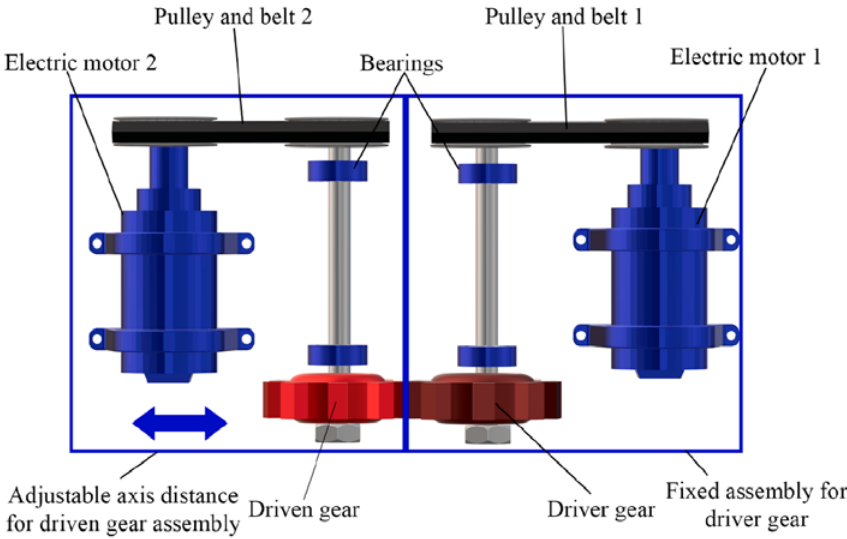
Figure 2. Gear test device (schematic figure).